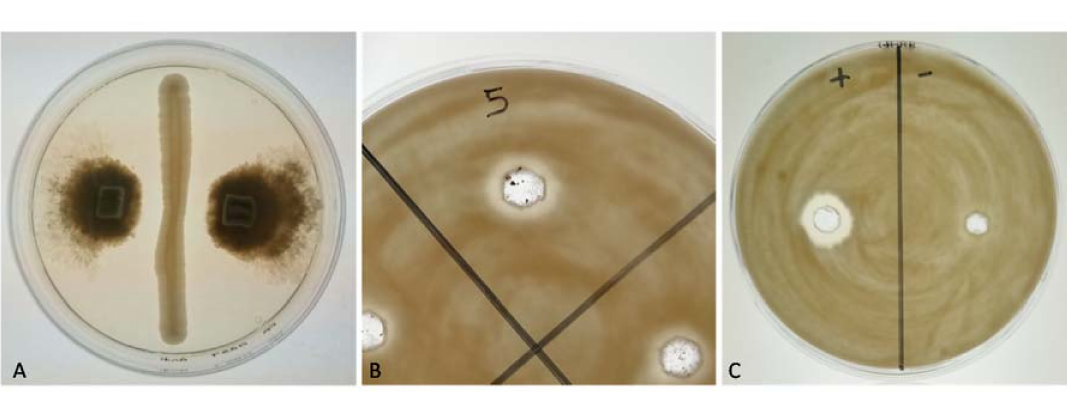
Figure 5. Antagonistic activity of P. odontotermitis OO5 against B. cinerea B16-14. ( A ) Growth inhibition on PDA; ( B ) agar diffusion assay with culture filtrate extracted with ethyl acetate; and ( C ) positive control (BASTA ® ) and negative control (5% v / v